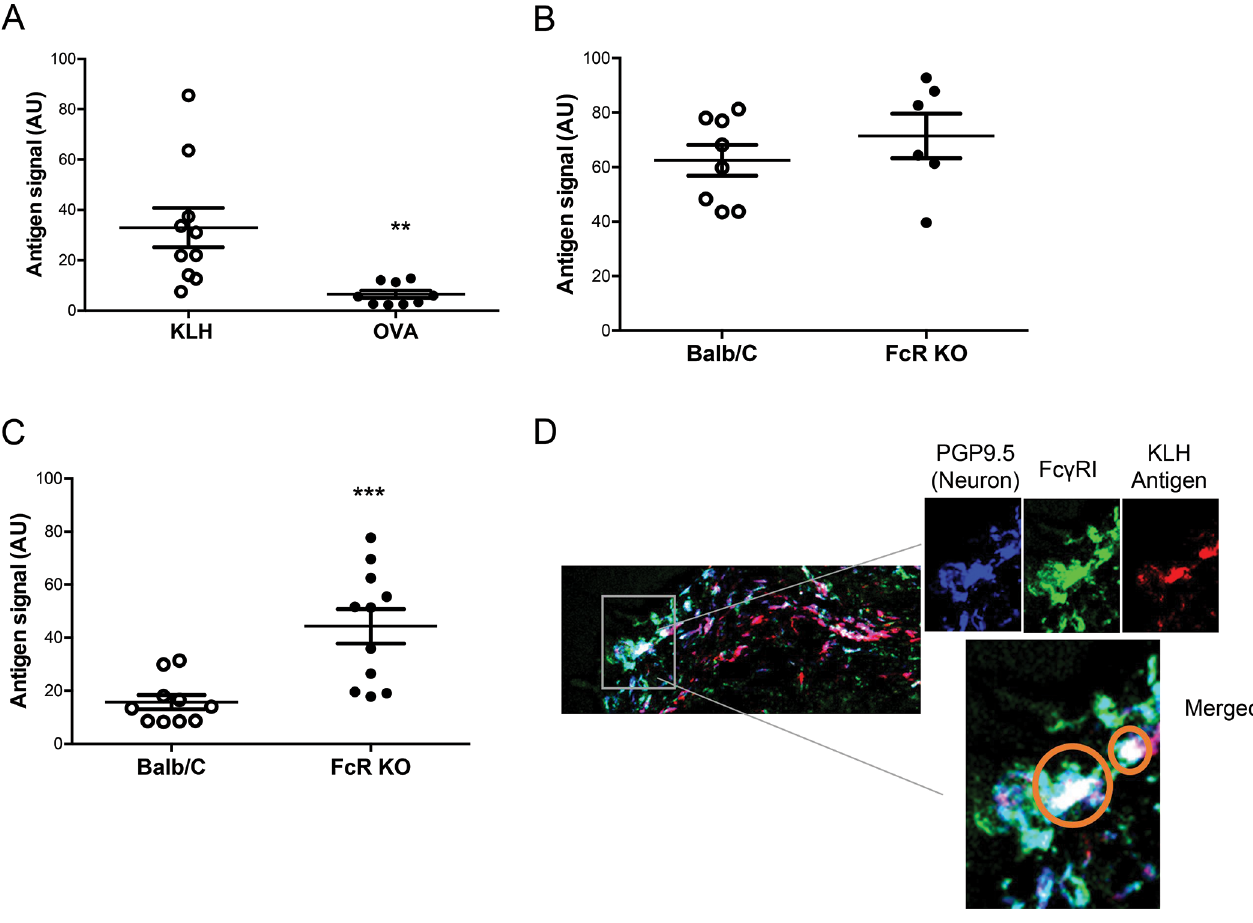
Figure 5. Neuronal Fc receptors play a role in antigen restriction. (A) Naïve mice were injected intraperitoneally with rabbit polyclonal anti-OVA antibodies, and 24 h later OVA-800CW or KLH-800CW was injected in the dorsum of the hind paw. The amount of OVA